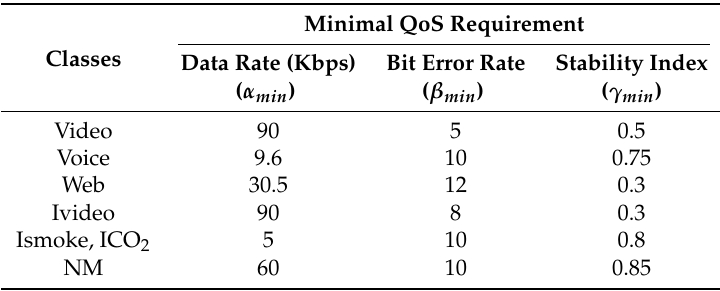
Table 2. QoS parameters for different SUs. NM, networking